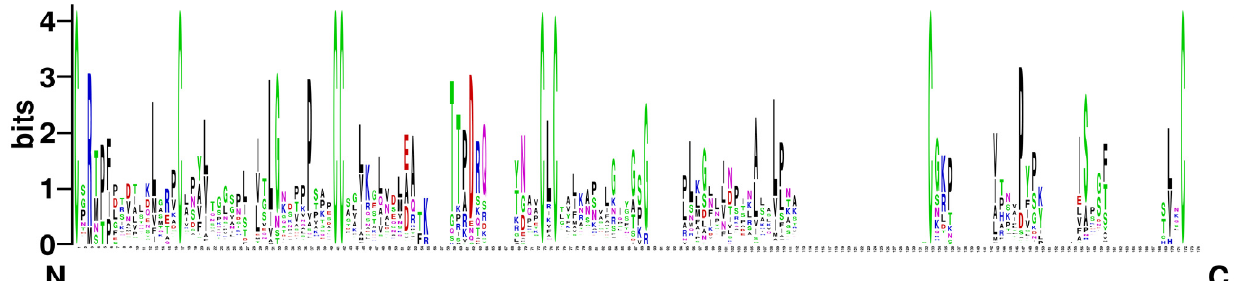
Figure 1. Sequence logos for the eight-cysteine motif (8CM) of BnLTP proteins. The height of each amino acid residue represents the degree of conservation. The numbers on the x -axis represent the positions in the 8CM. The y -axis shows the information content measured in bits.